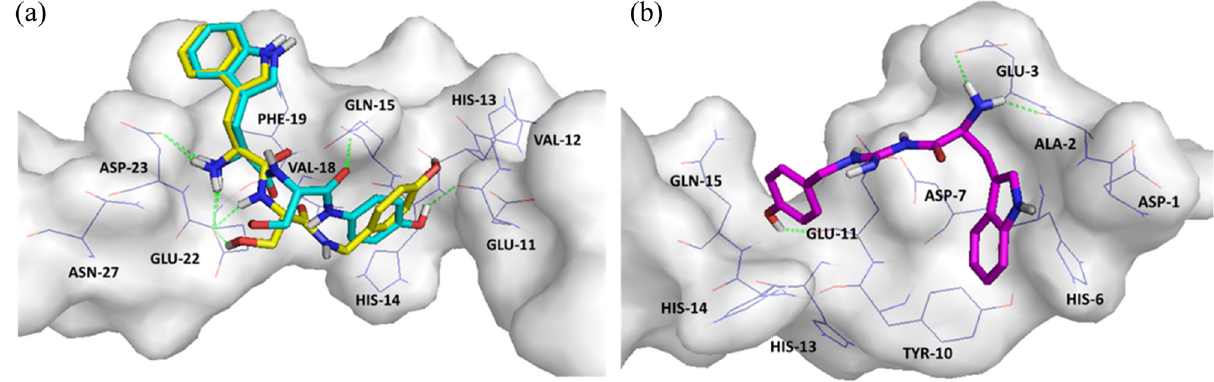
Figure 3: The binding modes of the lead compounds with A β peptide: ( a ) TSR1 ( cyan ) and TSR2 ( yellow ) ; ( b ) TGN2 ( magenta )